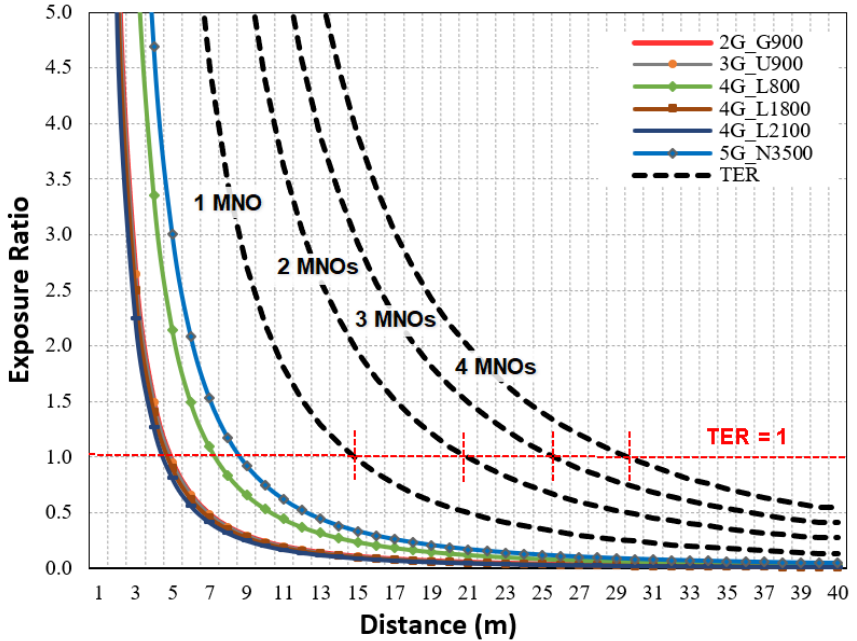
Figure 7. The exposure ratio in the main direction for multi-technology macro site with reference to ICNIRP limits for GP. ICNIRP limits for GP.